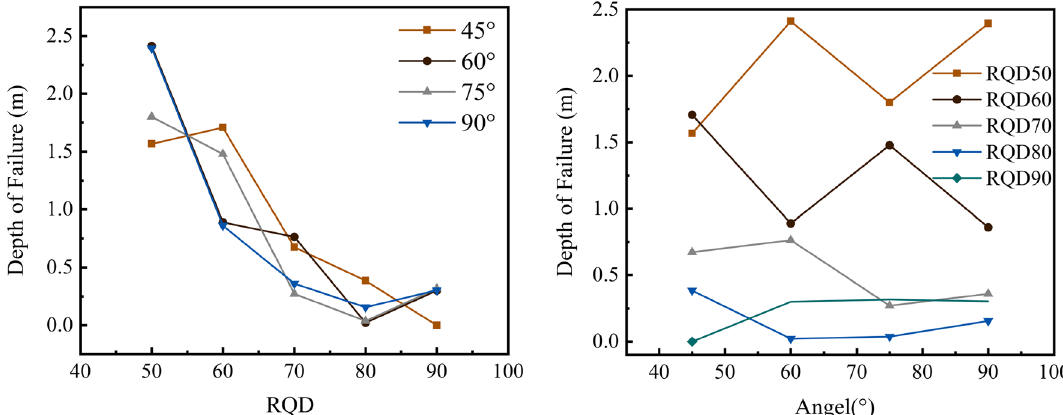
Fig. 34 Depth of failure with different θ , RQD values (for σ